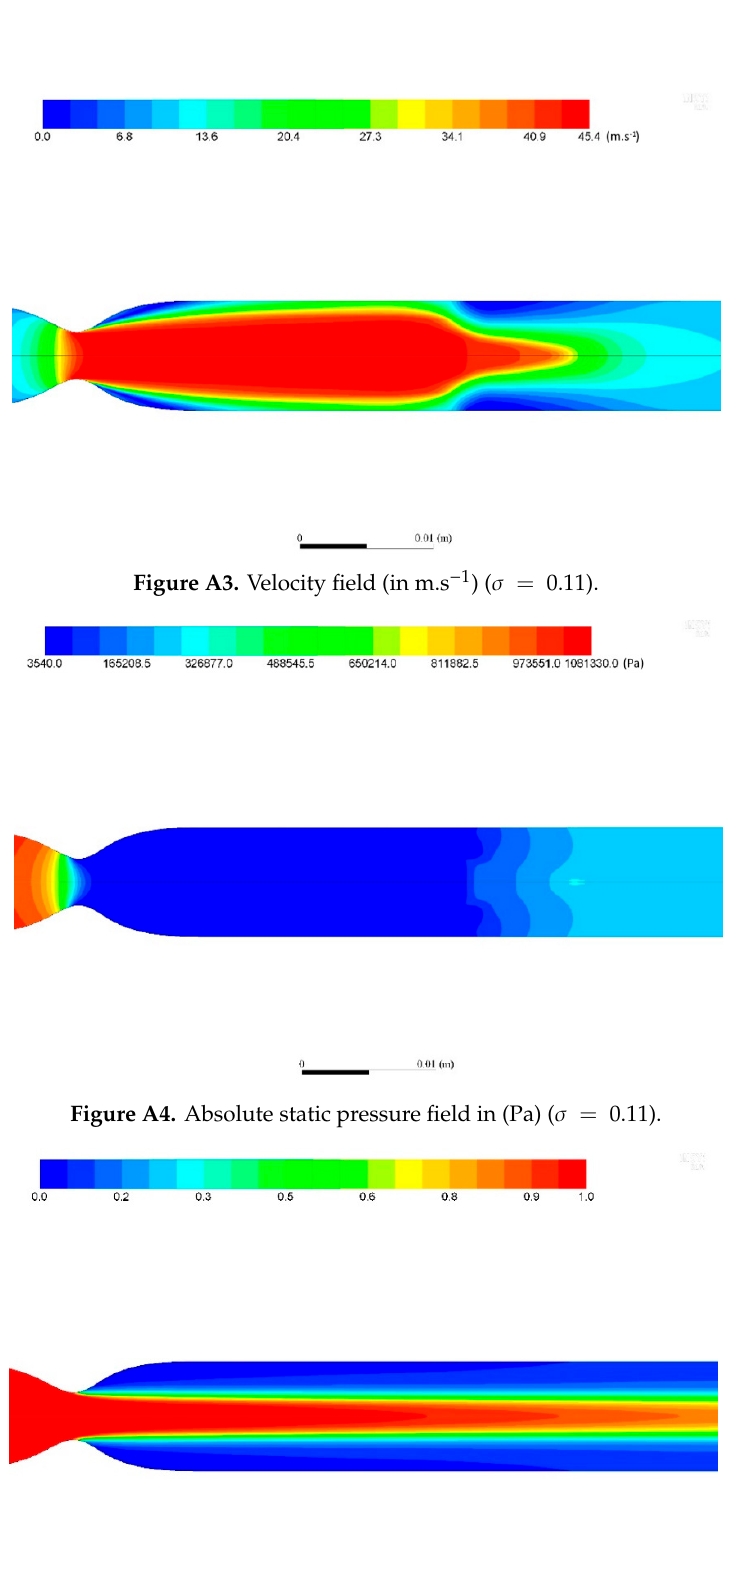
σ = 0.095), water = 1, vapor = Figure A5. Phase distribution ( 𝜎 = 0.095 ), water = 1, vapor = 0. Figure A5. Phase distribution ( Figure A5. Phase distribution ( 𝜎 = 0.095 ), water = 1, vapor = 0. Figure A5. Phase distribution ( 𝜎 = 0.095 ), water = 1, vapor = 0.